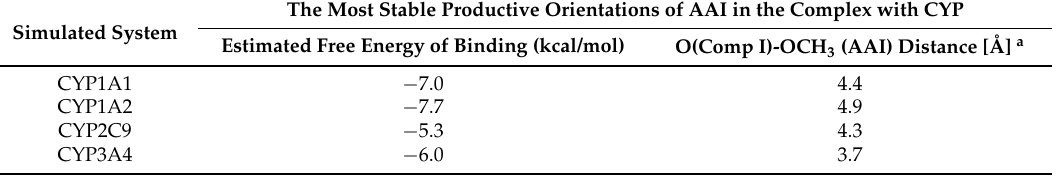
Table 2. The predicted binding free energies and distances facilitating O -demethylation of AAI bound in selected CYPs complexes.